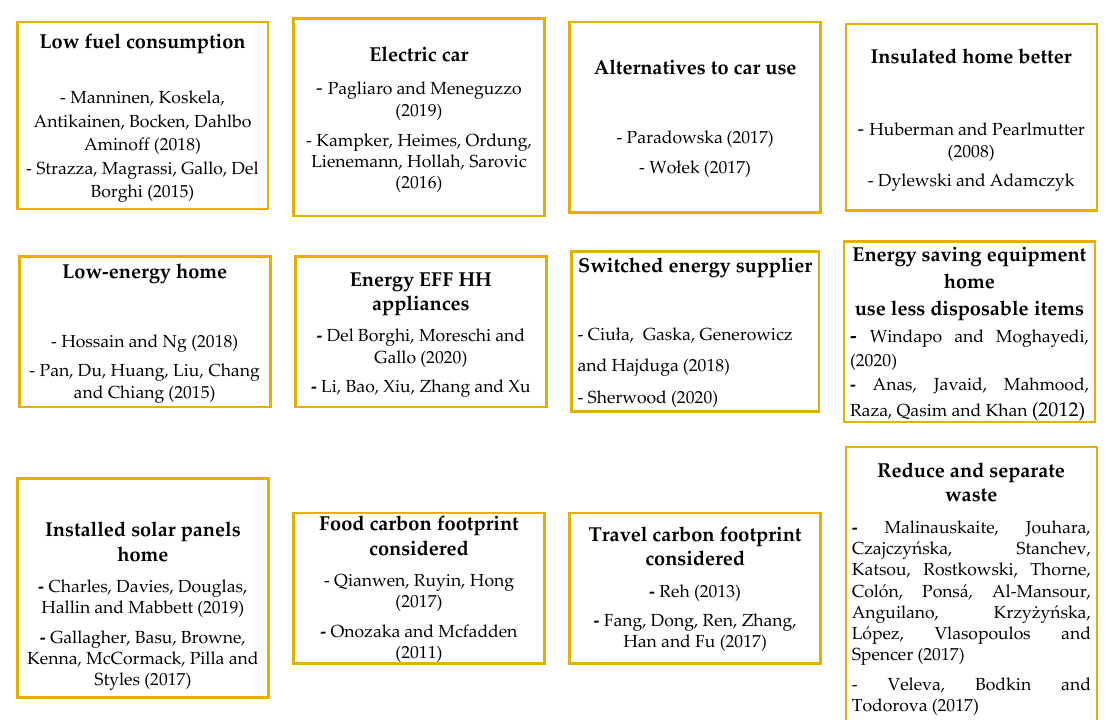
Figure 2. An overview of the most relevant studies concerning specific mitigation behaviour and its relation with the circular economy. Source: Author’s contribution.